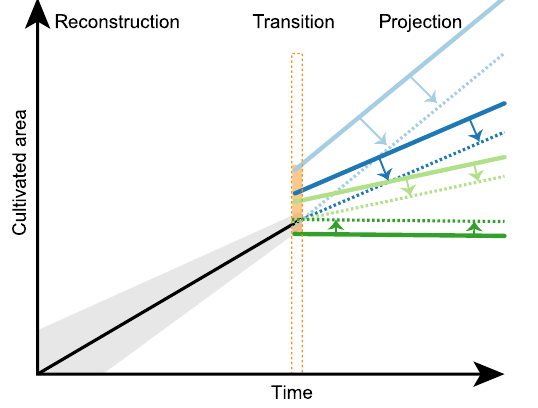
Figure 1. Simplified scheme of the harmonization process. Future projections from different models (solid colored lines) are smoothly connected (dashed colored lines) to the HYDE historical recon- struction (black line; grey shading represents the uncertainty range of LULCC history). Uncertainty about the extent and pattern of current land use and land cover (orange shading) is removed and the total area of cultivated land projected by the different models is